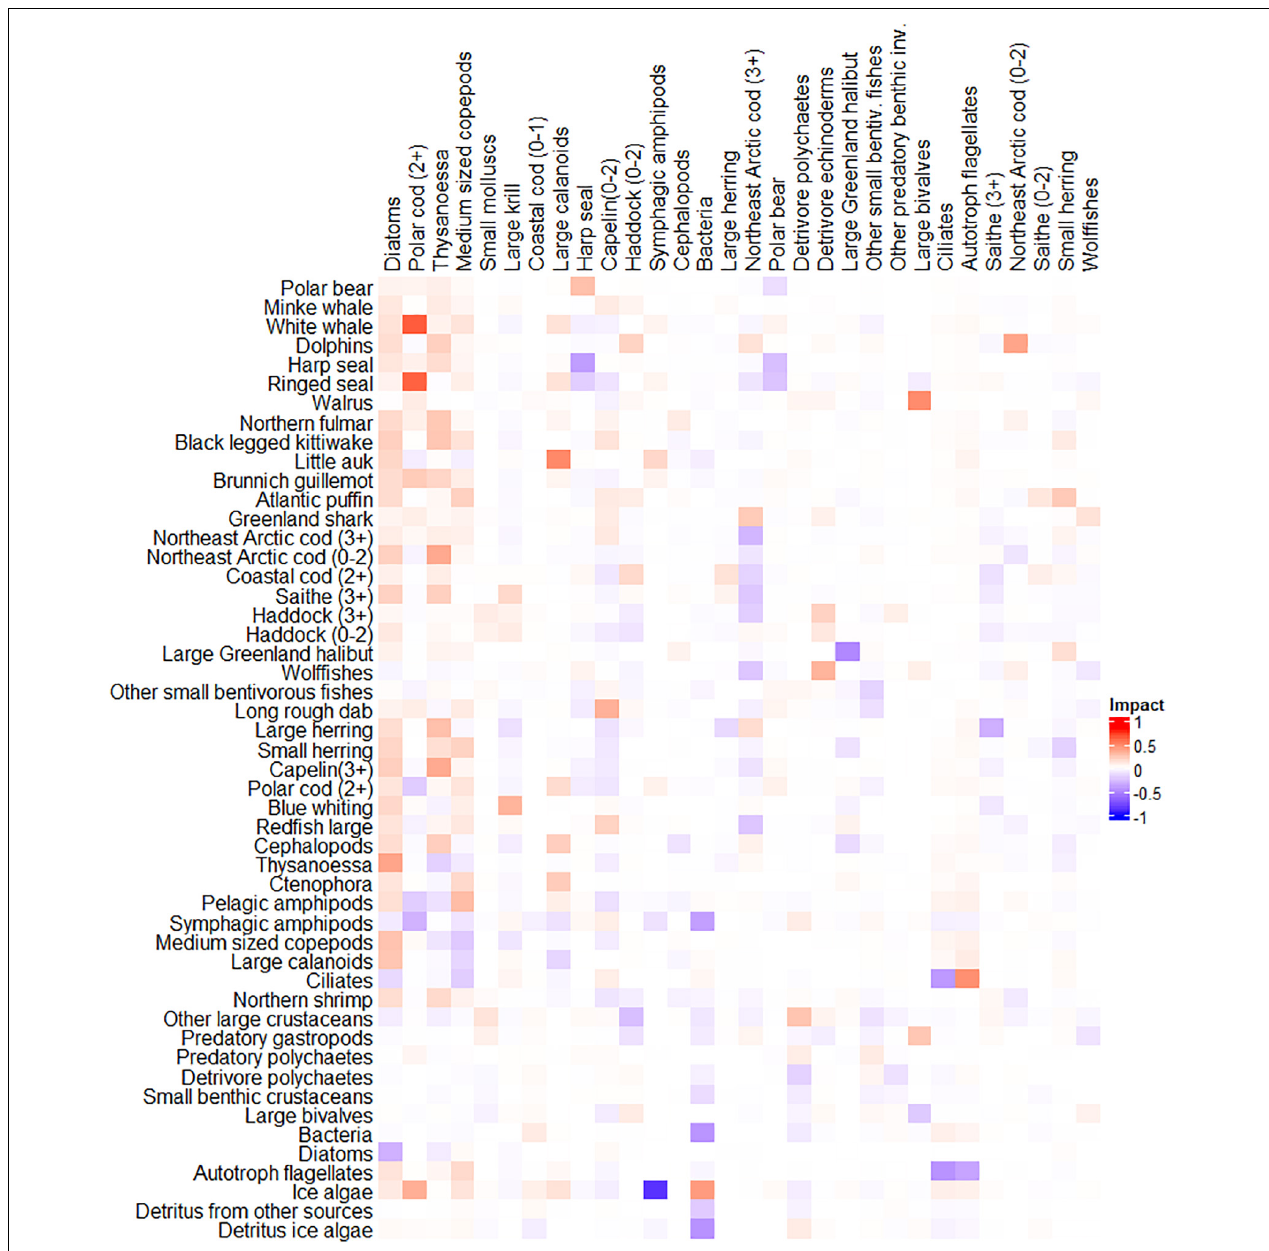
FIGURE 5 | Mixed trophic impact for the year 2000-model. Mixed trophic impacts are shown from the 30 ranked functional groups with highest total impact (column names) on 50 selected impacted functional groups